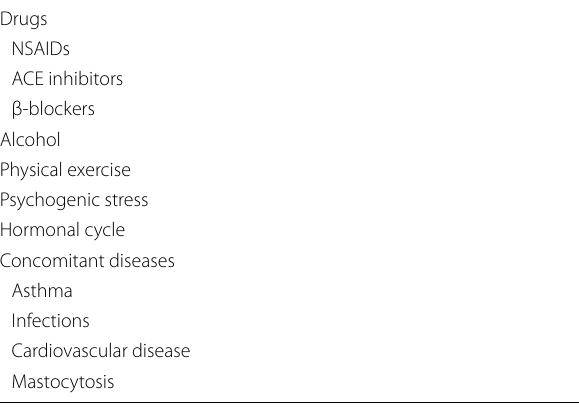
Table 2 Most common co-factors of